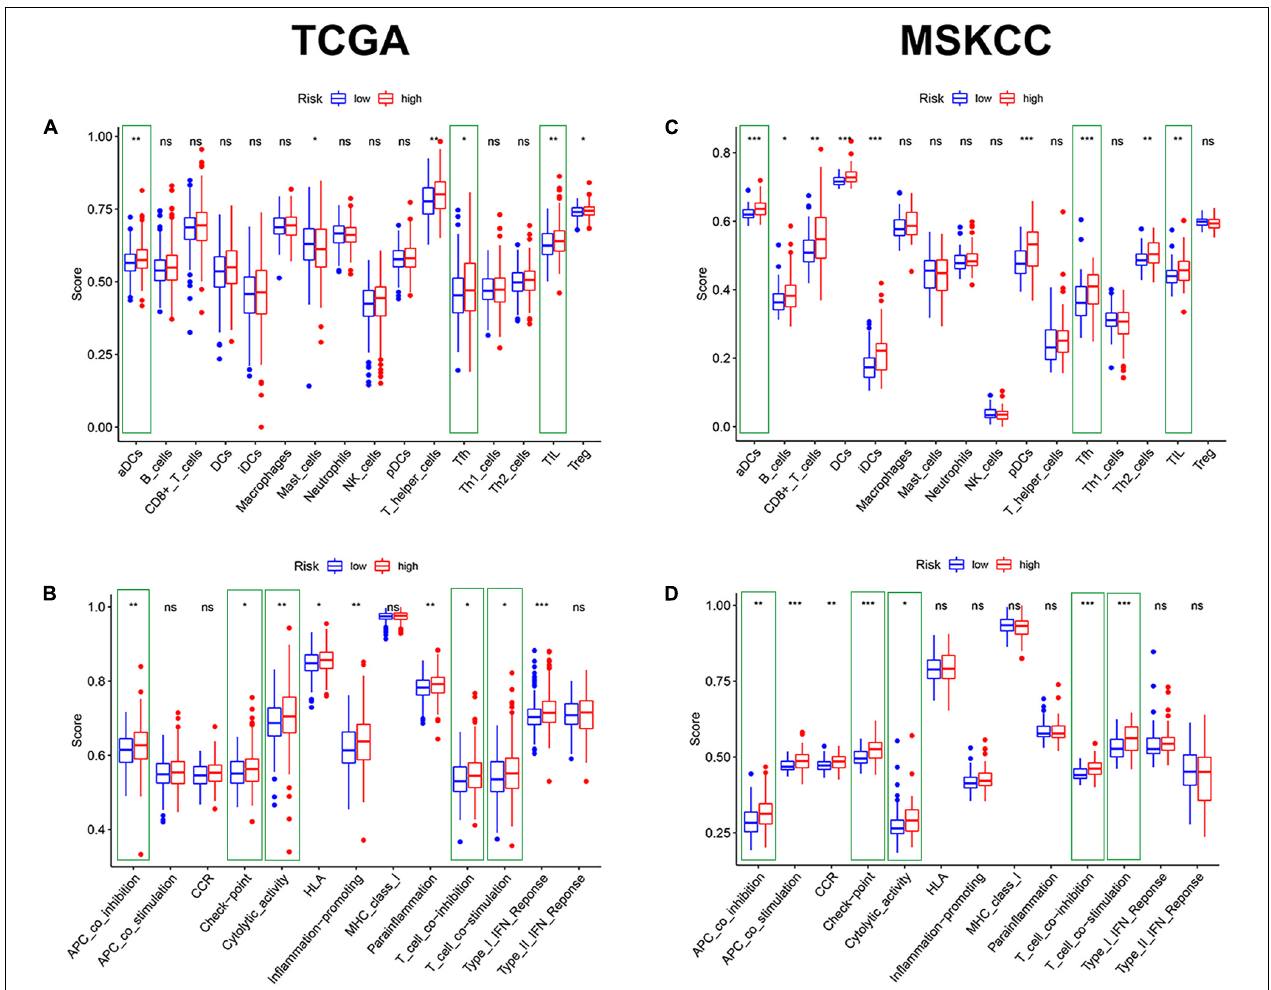
FIGURE 8 | The comparison of immune cells and immune function by single-sample GSEA (ssGSEA) in the two cohorts. (A,C) Enrichment results of immune cell score in the two cohorts. (B,D) Enrichment results of immune function score in the two cohorts (* p < 0.05; ** p < 0.01; *** p <